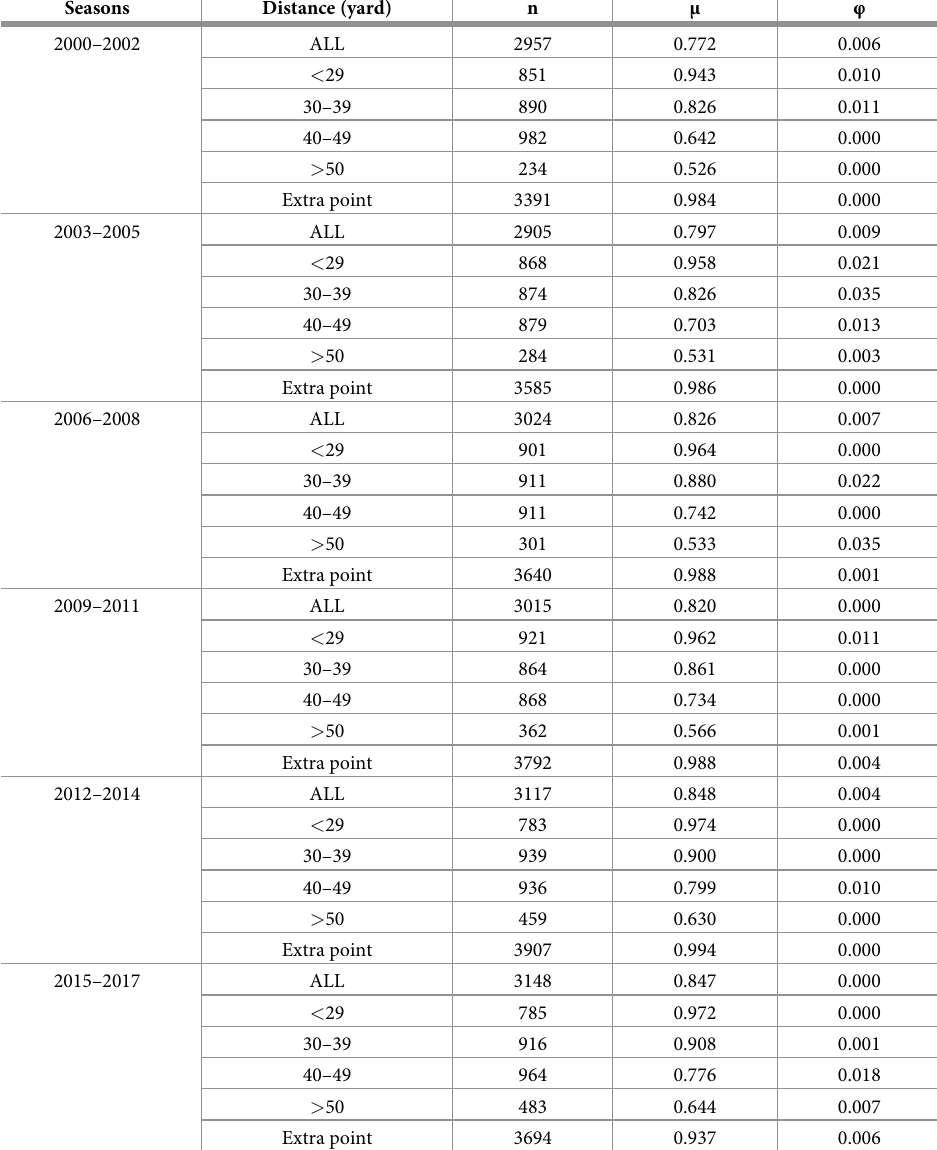
Table 5. Beta-binomial